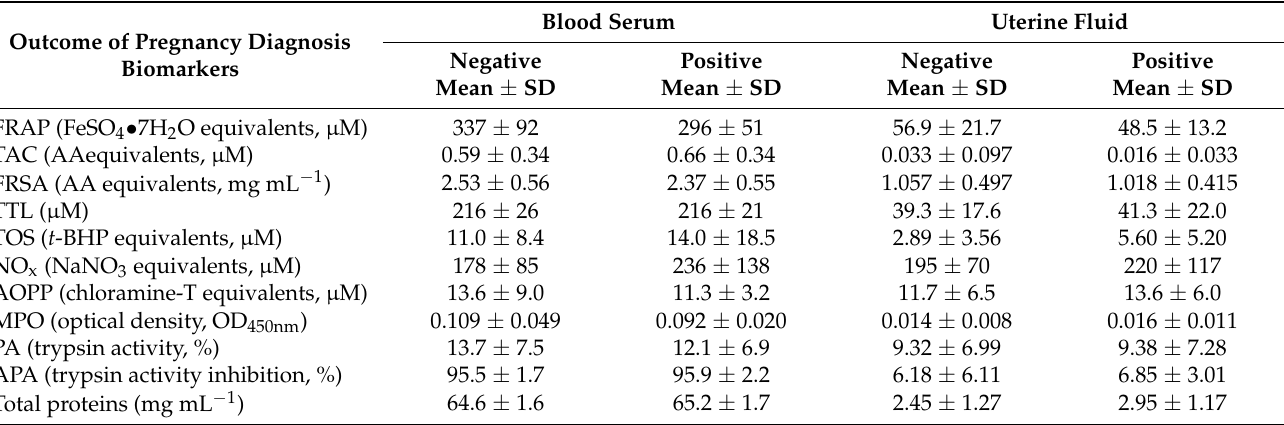
Table 5. Mean ( ± SD) values of the oxidative profile and proteolysis regulator biomarkers assessed in the blood serum and the uterine fluid of mares with negative (n = 21) and positive (n = 12) outcomes for the pregnancy